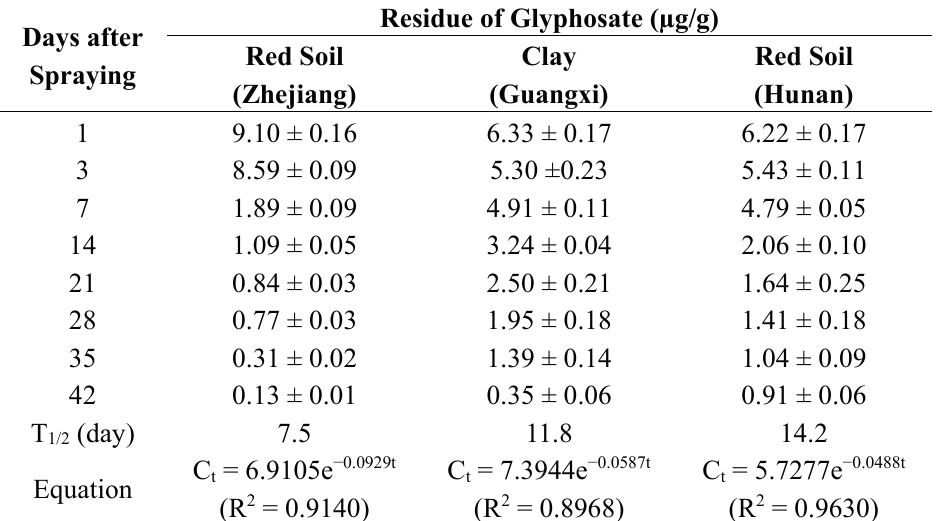
Table 4. Degradation dynamics of glyphosate aqueous solution in different type of